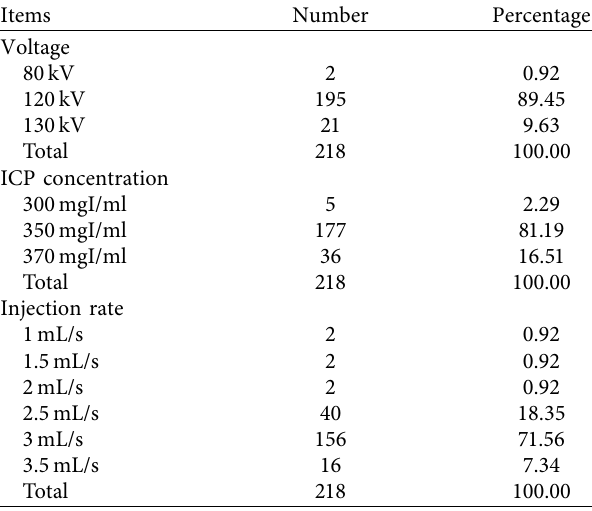
Table 3: Acquisition and ICM use